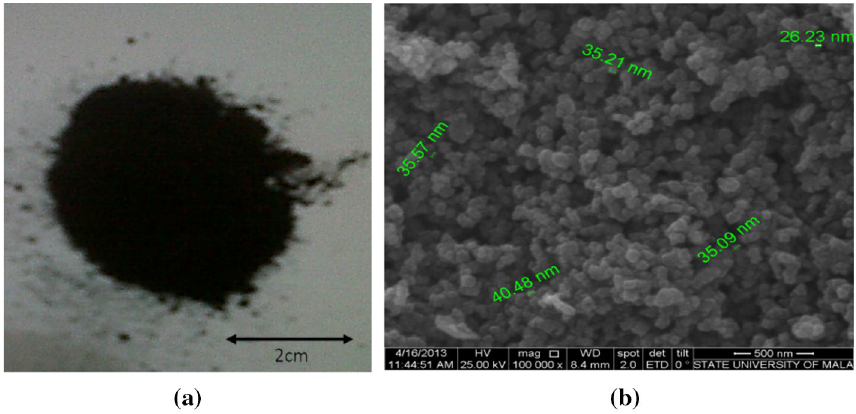
Figure 3. Magnetite from the electrochemical cell ( a ) and corresponding SEM image ( b ) at 100,000 times magnification.